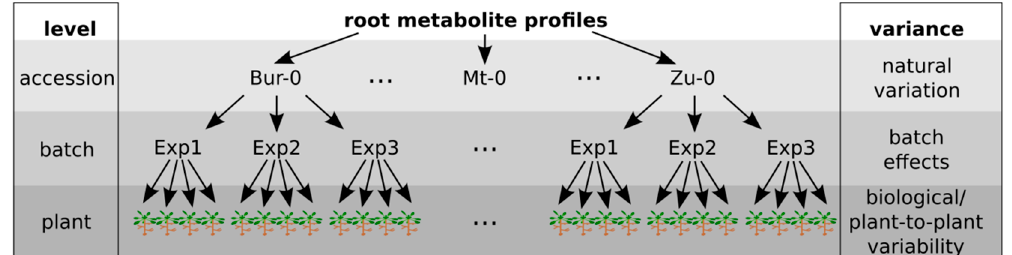
Figure 1. Nested experimental design with three levels. Each variance level had multiple replicates—to assess natural variation, 19 accessions of Arabidopsis thaliana ( A. thaliana ) were grown. Three independent biological experiments were performed to estimate non-biological variance derived from the experimental batch. To assess individual variability, four plants were harvested in each biological experiment for each accession. Single-plant root extracts were subjected to liquid chromatography-coupled mass spectrometry (LC/MS) and gas chromatography-coupled mass spectrometry (GC/MS) analysis.